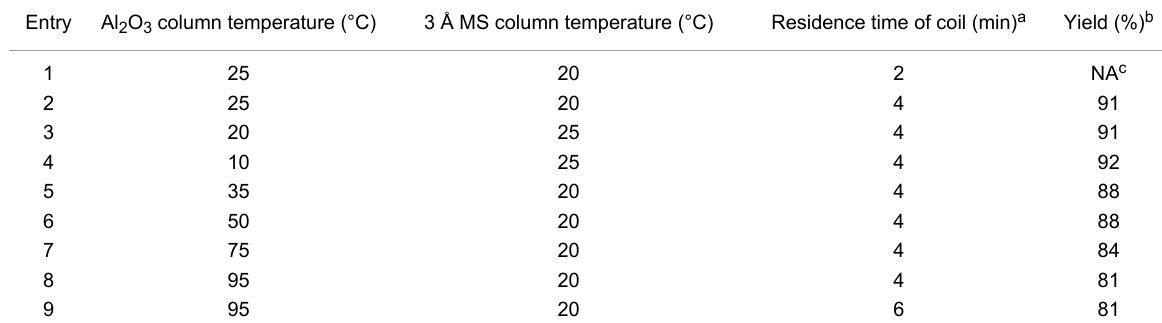
Table 2: Screened conditions for formation of 5 starting from acetone and